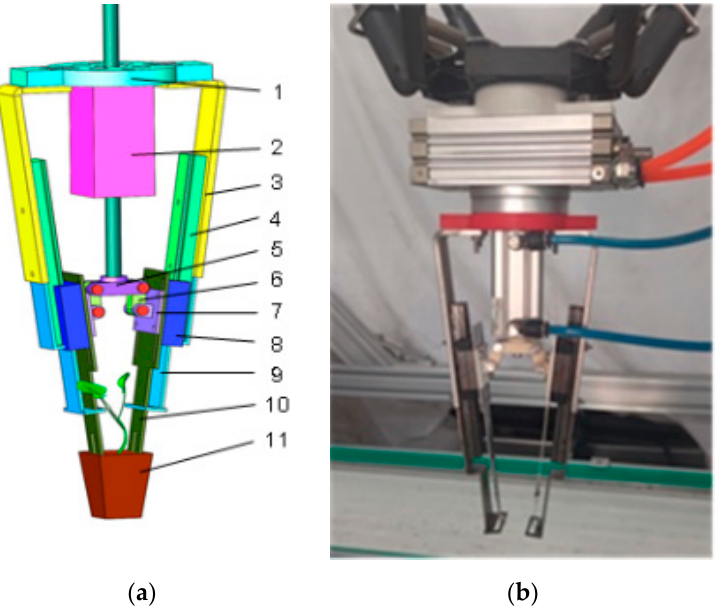
Figure 4. ( a ) A 3D modeling view of the end effector. ( b ) Finished product view of the end effector. 1. Cylinder connecting plate; 2. double-action cylinder; 3. side plate; 4. slide rail; 5. cylinder tail; 6.